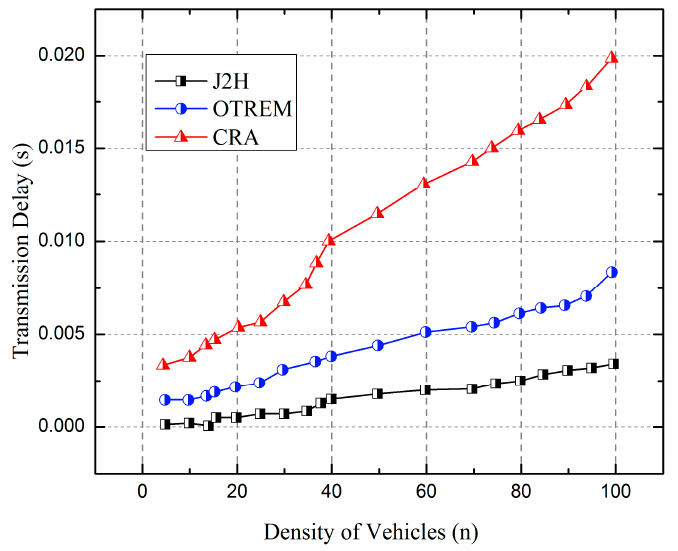
Figure 5. Analysis of transmission delay in transmitting alert messages with low density of vehi- cles.